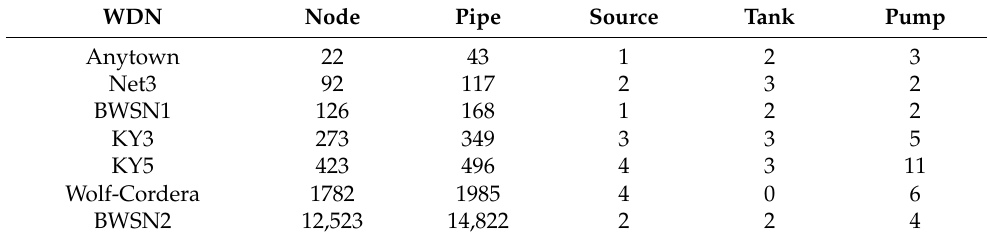
Table 2. Benchmark WDN for CSI. WDN Node Pipe Source Tank